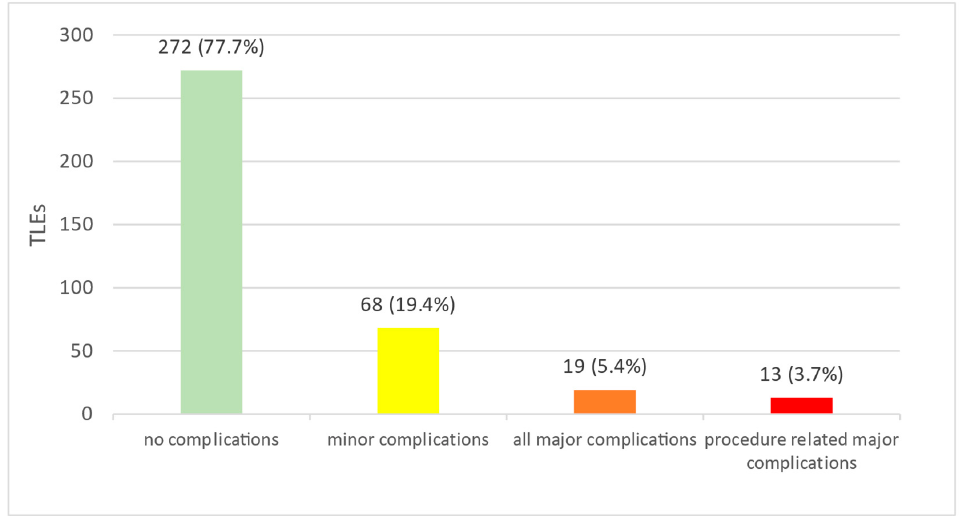
Figure 3. Complications following transvenous lead extraction. Out of 350 TLE performed (100%), 272 TLEs (77.7%) went flawlessly. A total of 68 TLEs (19.4%) resulted in minor complications, 19 TLEs (5.4%) resulted in major complications, and a subgroup of 13 TLEs (3.7%) resulted in major procedure- related complications. One procedure may be listed in multiple groups. TLE: transvenous lead